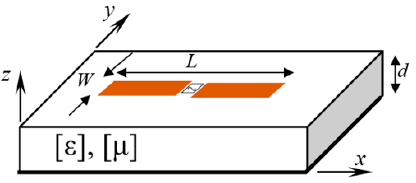
Figure 1. Printed dipole on uniaxial electrical- and magnetic- anisotropic substrate.